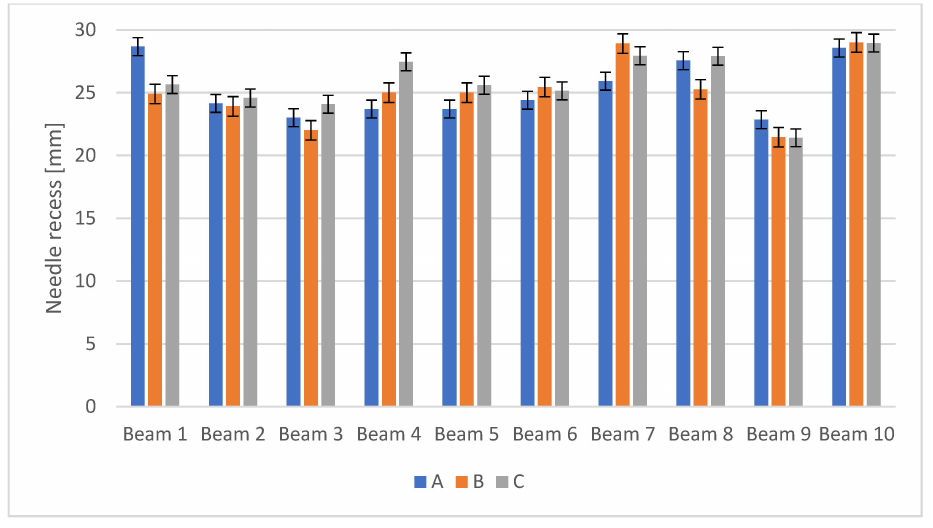
Figure 13. Needle recess from the side of pine wood beams. A, B, C—measurement points—the needle recess across fibres.